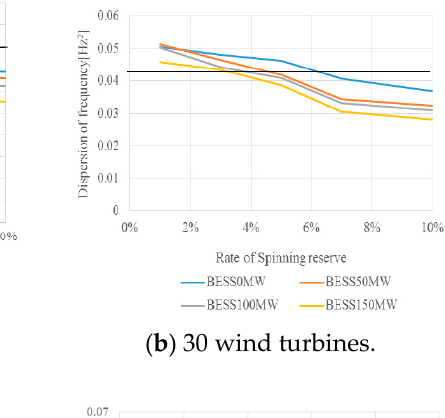
Figure 12. Rate of dispersion under ±1 of 5.7 m/s wind turbine.